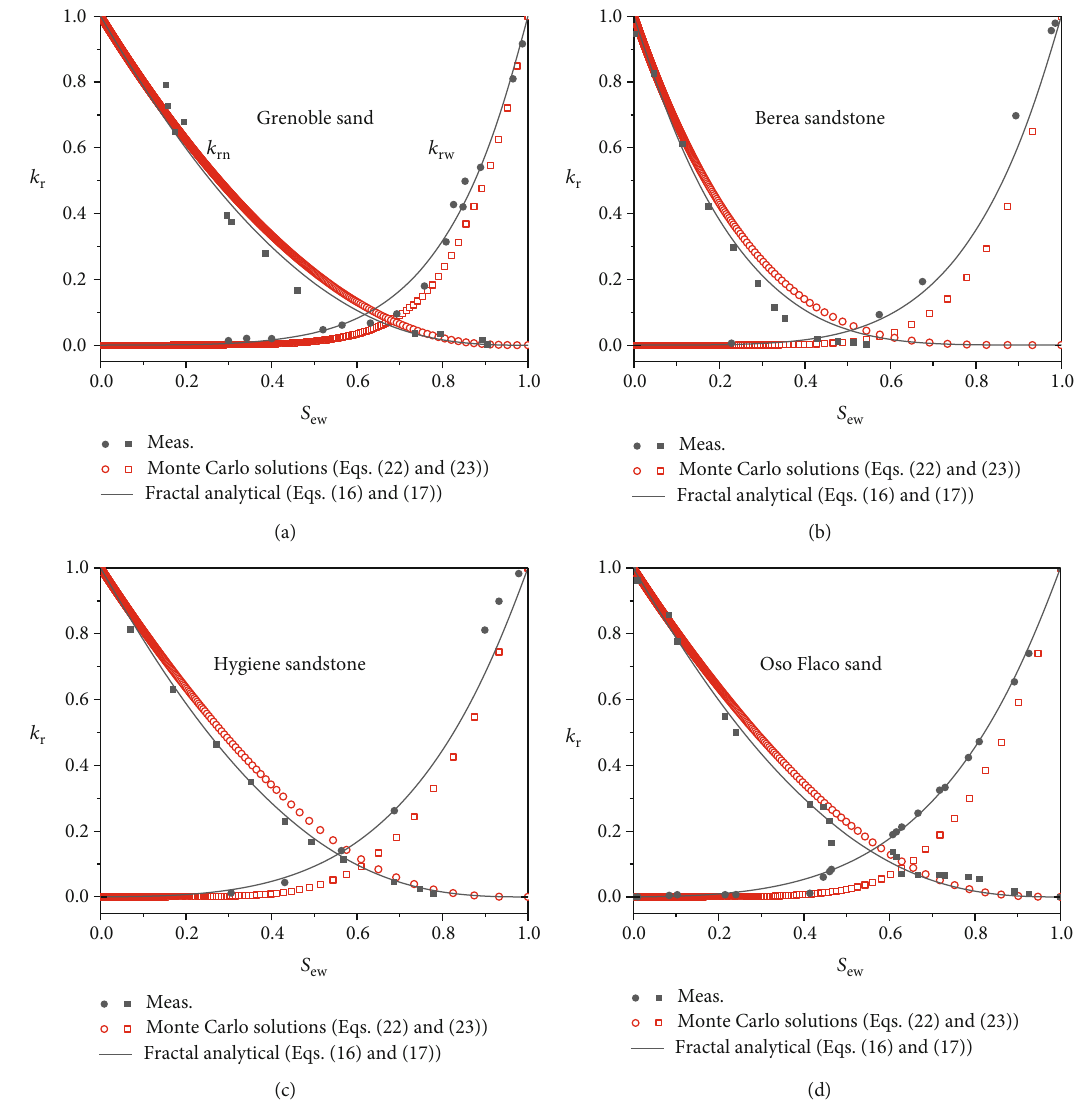
Figure 4: Predicted relative permeability for water-air system and the comparison to the experimental